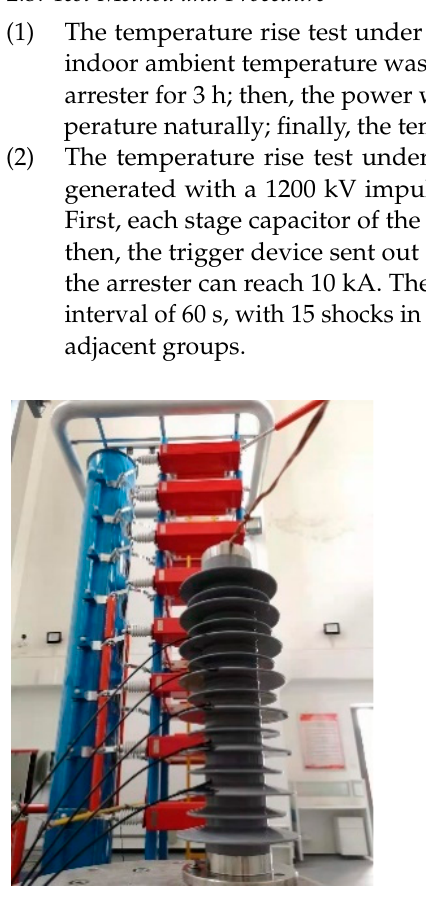
Figure 3. Fluorescent optical fiber temperature measuring system.